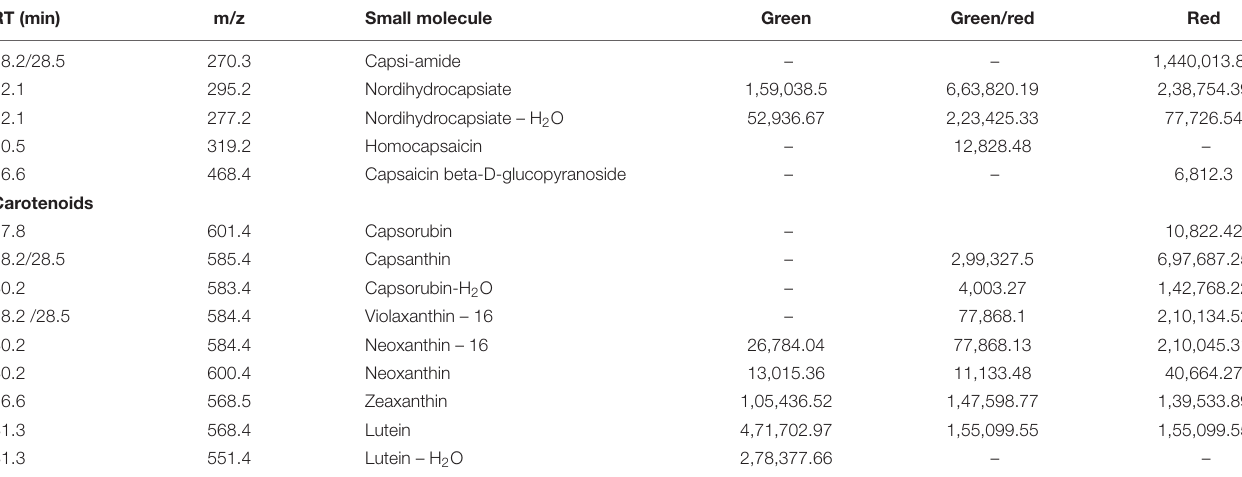
TABLE 2 | List of the most abundant metabolites identified by LC-MS analysis. Small molecule Green